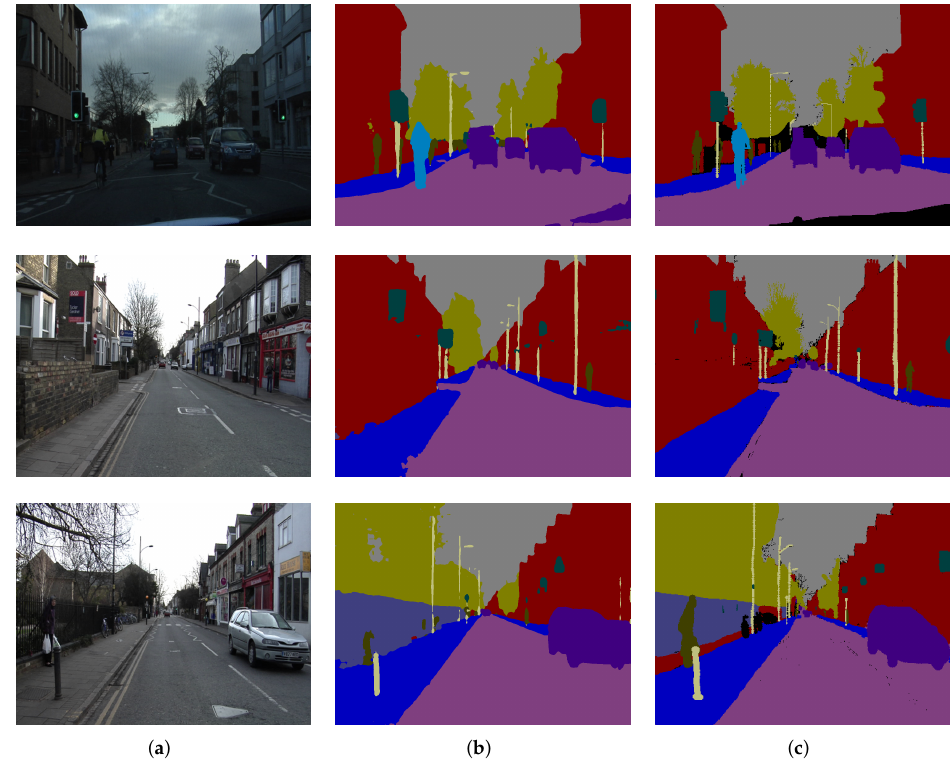
Figure 3. Semantic segmentation results on the CamVid. ( a ) Original images. ( b ) EDBNet. ( c ) Ground truth.